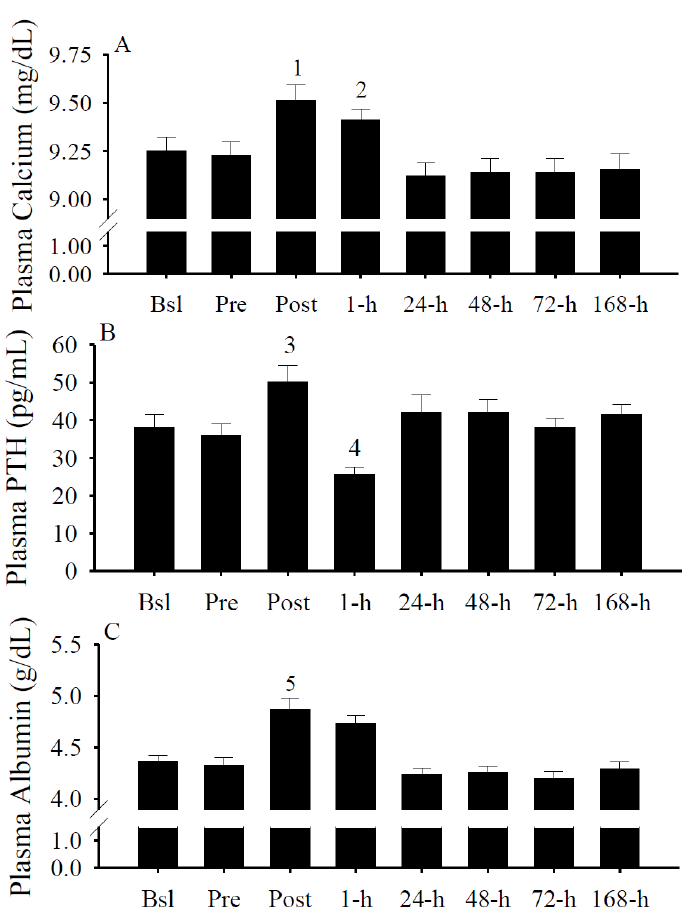
Figure 7. Plasma calcium (mg/dL), parathyroid hormone (PTH; pg/mL), and albumin (g/dL) concentrations. ( A ) Total plasma calcium concentrations were significantly increased at Post ( 1 p < 0.05 vs. Bsl, Pre, 24-h, 48-h, 72-h, and 168-h) and 1-h ( 2 p < 0.05 vs. 24-h, 48-h, 72-h, and 168-h). ( B ) Plasma PTH concentrations were significantly increased at Post ( 3 p < 0.05 vs. Bsl, Pre, 1-h, and 72-h) and significantly decreased at 1-h ( 4 p < 0.05 vs. 24-h, 48-h, and 168-h). ( C ) Plasma albumin concentrations were significantly increased at Post ( 5 p < 0.05 vs. Bsl, Pre, 1-h, 24-h, 48-h, 72-h, and 168-h). Data presented as mean ±